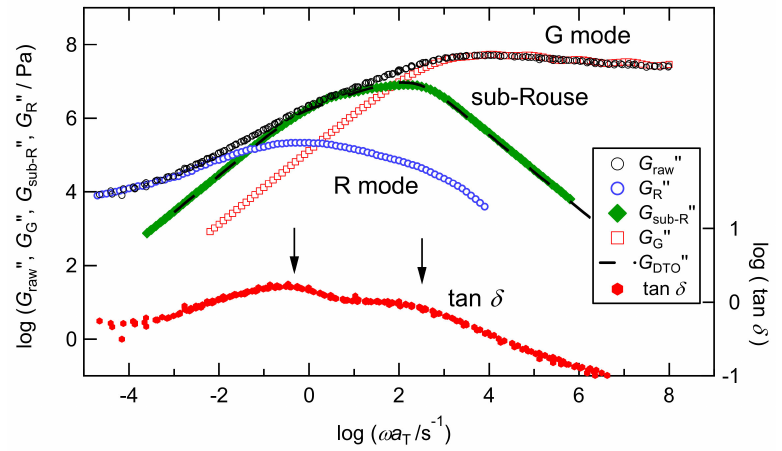
Figure 6. Reduced frequency ω a T dependence of G (cid:48)(cid:48) (Graw (cid:48)(cid:48) ) and tan δ for molten PC 4 -TFSI at the reference temperature, 80 ◦ C. Three-component G (cid:48)(cid:48) functions ( G R (cid:48)(cid:48) , G sub-R (cid:48)(cid:48) , G G (cid:48)(cid:48) ) determined by modified-stress-optical-rule are overlayed on the raw data. The black dashed line represents the DTO model calculation used in the previous study